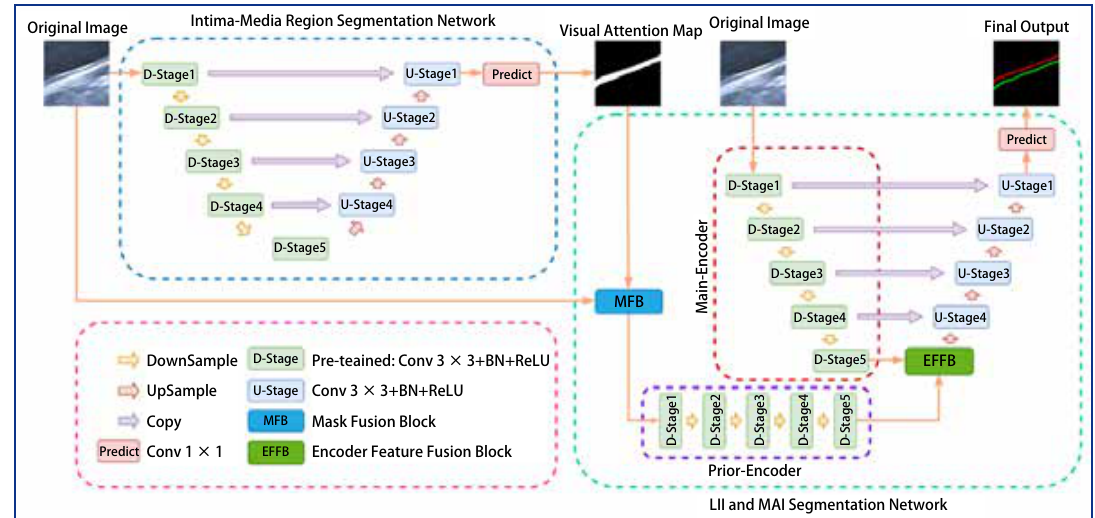
Figure 3 Network architecture of NAG-Net